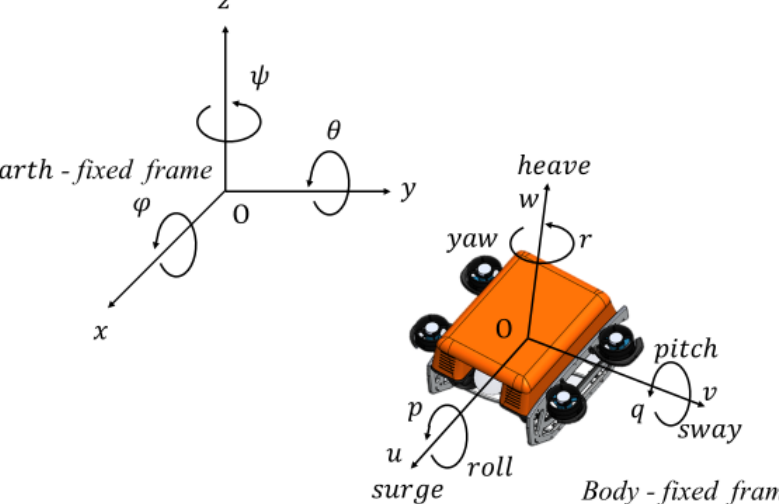
Figure 1. Autonomous underwater vehicles (AUVs) in Body-fixed and Earth-fixed frames. The body velocity v of an object can be converted to the inertial velocity